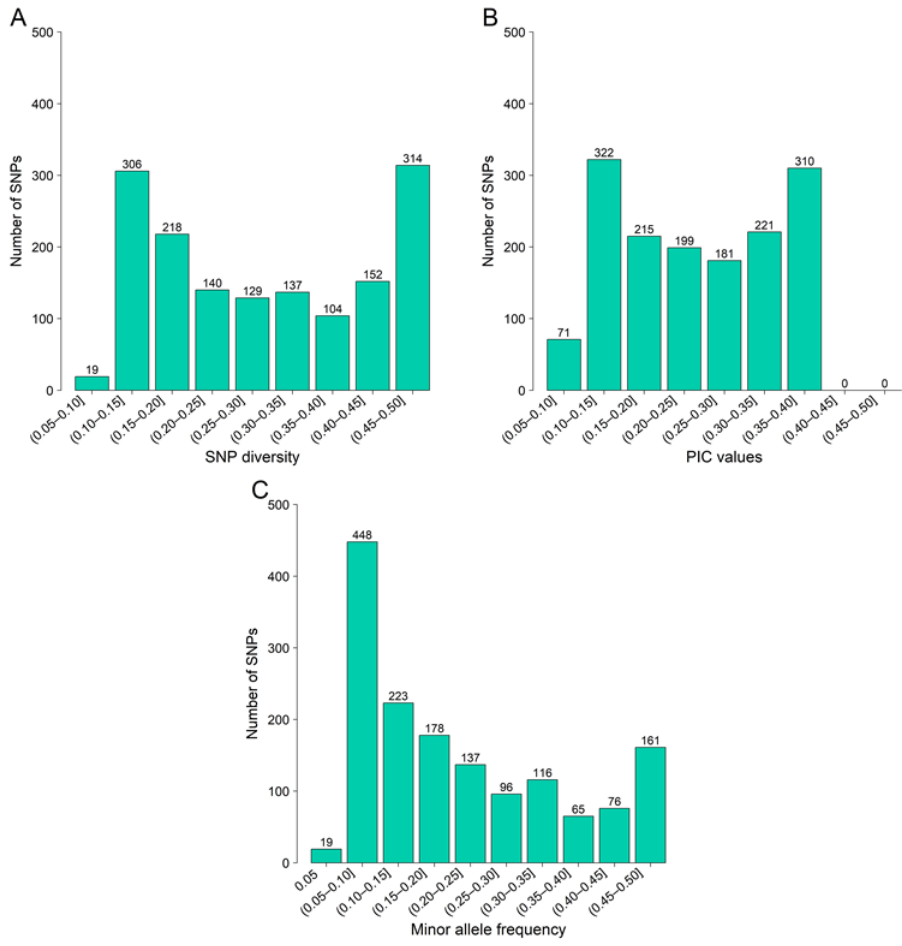
Figure 2. Distribution of 1519 SNP markers estimated for all 73 B. gymnorhiza accessions. ( A ) SNP diversity; ( B ) polymorphic information content (PIC); ( C ) minor allele frequency.